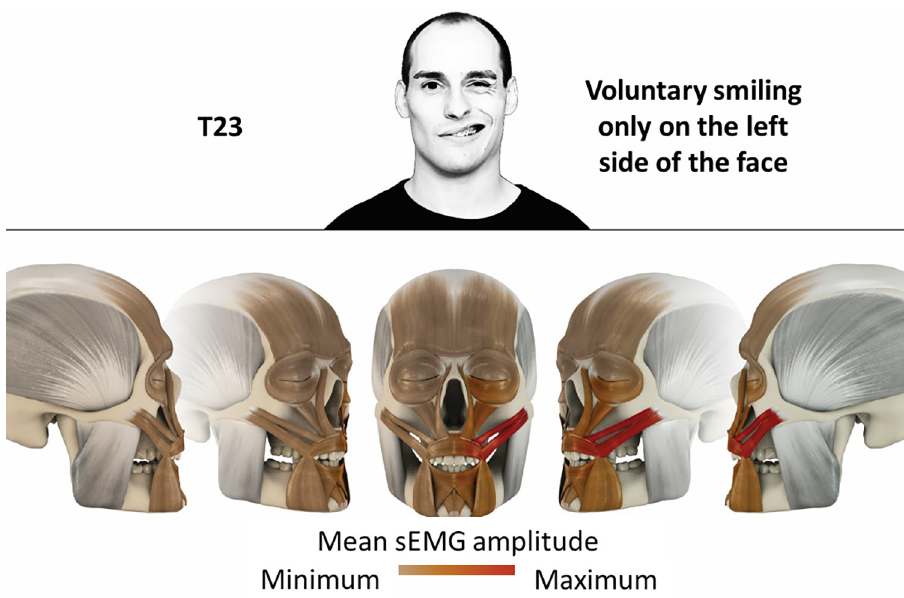
Fig 24. Color-coded facial muscle activation pattern of task T23. Voluntary smiling only on left side of the face. Animation by Jonas Laustro¨er.